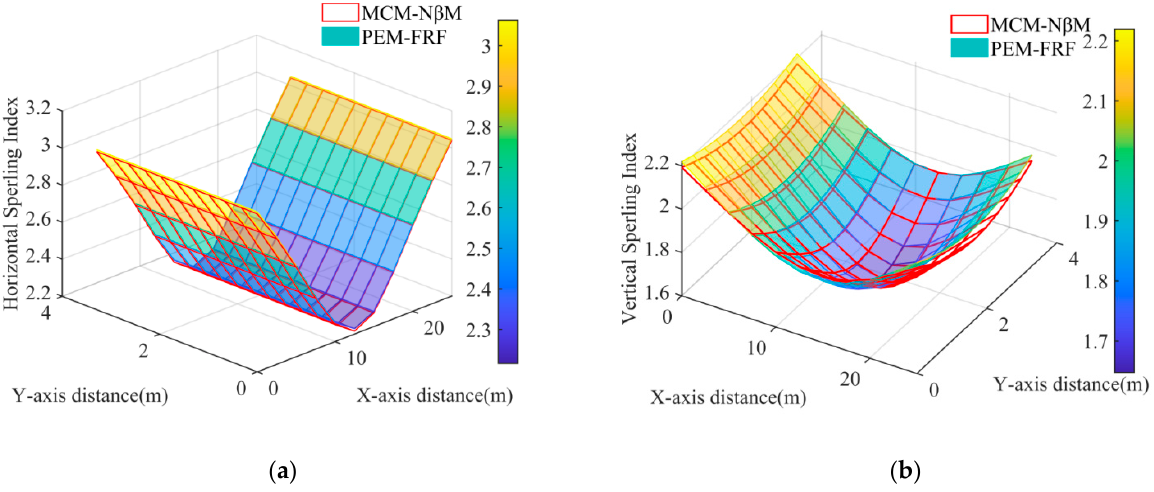
Figure 6. Zonal distribution of car-body Sperling index using MCM and PEM: ( a ) horizontal Sper- ling index; ( b ) vertical Sperling index.